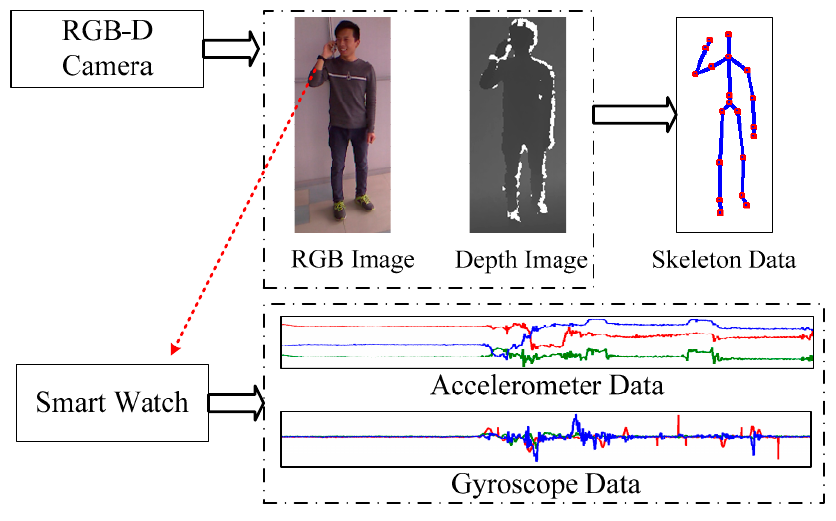
Figure 1. Introduction of the monitoring system.